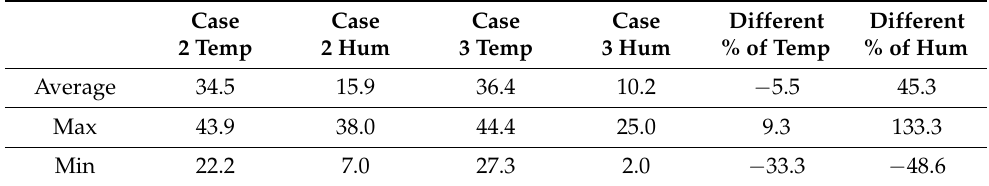
Table 5. Weather data analysis for two locations in Hail city.